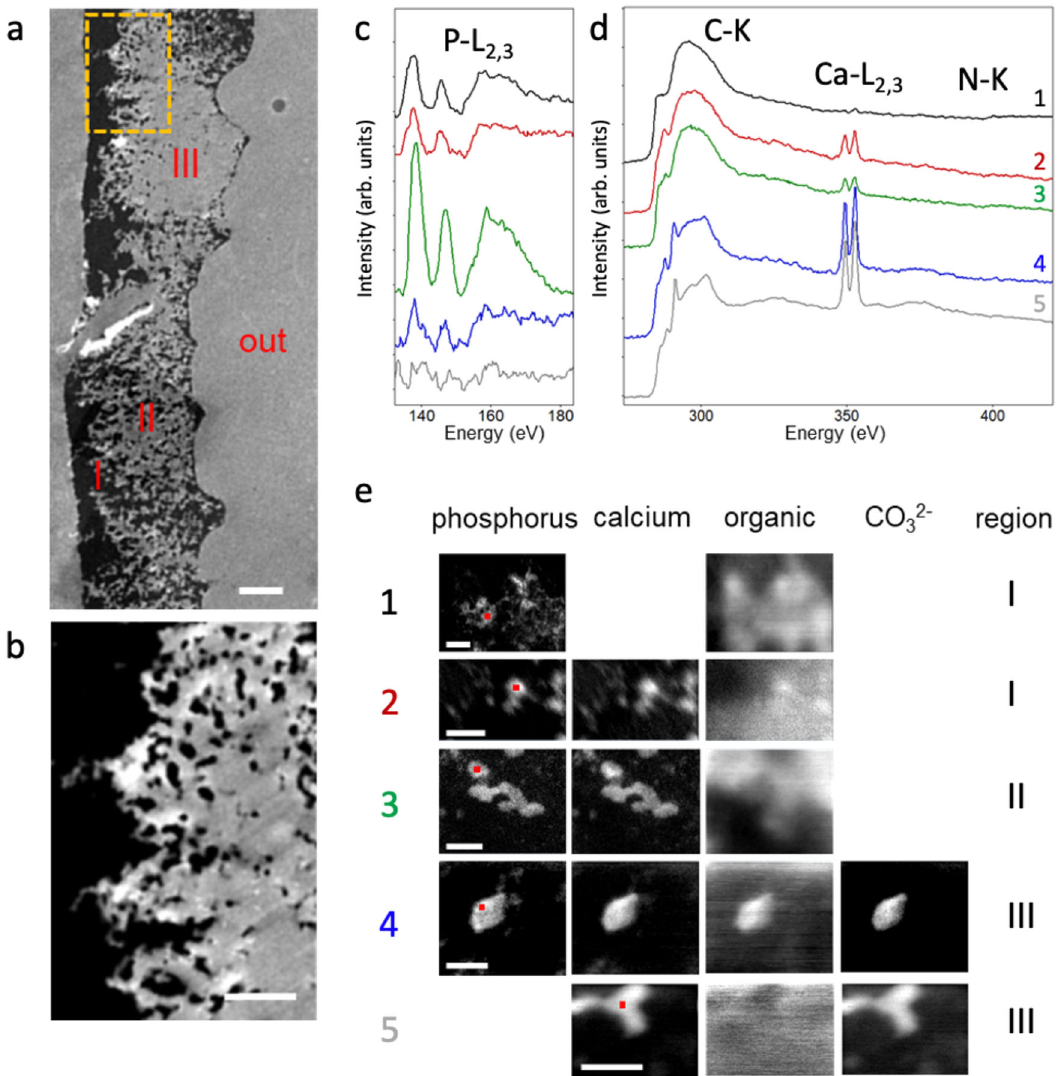
Fig. 4 Chemical composition of 48 hpf larval by STEM-EELS. a HAADF image of an area across the 48 hpf larval shell of H. tuberculata . The outer part of the shell is indicated by “ out ” . b Magni fi ed view of the part of the shell marked with a dashed orange rectangle on ( a ). c EEL spectra in the energy range corresponding to phosphorus (L 23 -edge), d carbon (K-edge), calcium (L 23 -edge) and nitrogen (K-edge) for the positions indicated by the red squares in the corresponding maps (1 – 5) in ( e ). The presented data sets correspond to the most common patterns observed in the sample. e Maps obtained from EELS data showing the distributions of phosphorus, calcium, organic species and carbonate in different areas across the larval shell. The region where each feature is commonly found is indicated by the labels I, II, and III in ( a ). Scale bar = 1 µ m for ( a ), 0.5 µ m for ( b ) and 50 nm for ( e